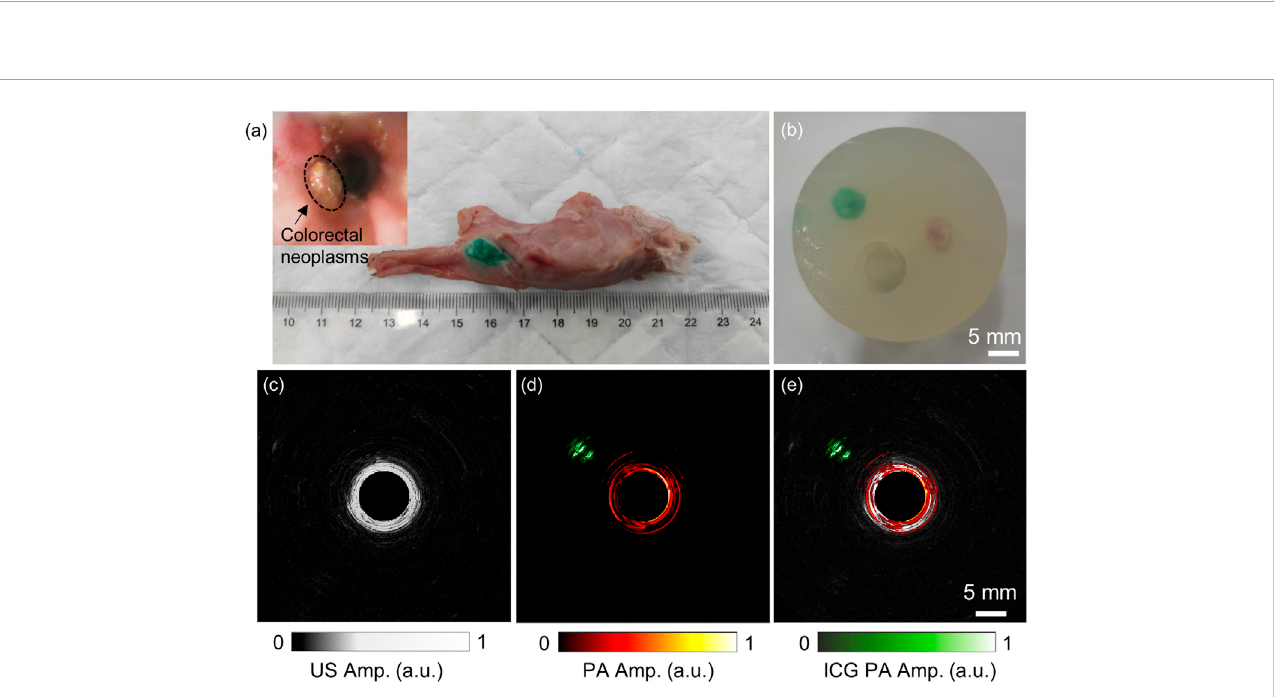
FIGURE 6 Ex-vivo endoscopic imaging results of the ICG-labeled rabbit VX2 tumor. (A) The photo image of the excised rectum and the tumor injected with ICG. The small picture in the top left corner shows the endoscopic image of the tumor in situ . (B) The phantom containing both the tumor and a piece of normal tissue; (C) and (D) show the obtained ultrasound and photoacoustic images of the phantom. (E) The fused photoacoustic and ultrasound image of the phantom. The laser wavelength of the photoacoustic image was 800